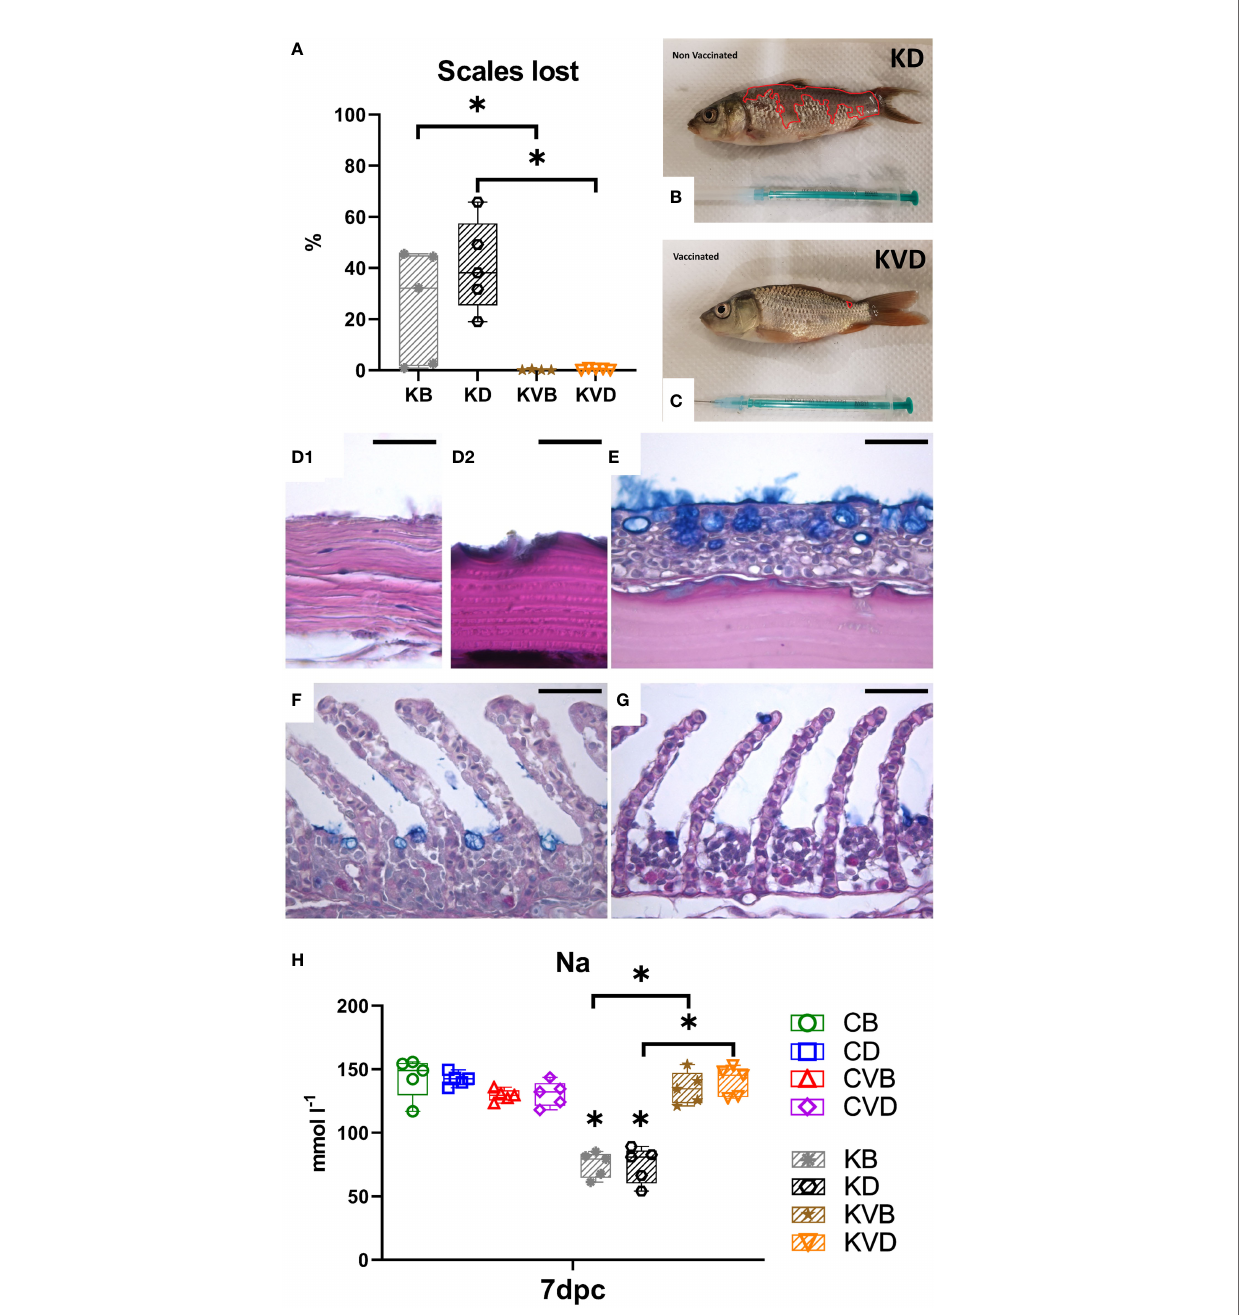
FIGURE 5 | Macroscopic, pathohistological and pathophysiological effect of the CyHV-3 challenge at 7 dpc. (A) Percentage of the body integument where scales were lost during the challenge. The surface area of (B) non-vaccinated and (C) vaccinated fi sh which lost scales are outlined in red. (D 1 ) Histology of the skin of non- vaccinated, CyHV-3 challenged fi sh which lost scales. (D 2 ) Histology of the skin of non-vaccinated, CyHV-3 challenged fi sh which had intact scales but lost the epithelium. (E) Histology of the skin of vaccinated fi sh showing scales covered with epithelium. (F) Histology of the gills of non-vaccinated, CyHV-3 challenged fi sh showing thickening of secondary lamella and some increase in cell proliferation in the intralammellar spaces. (G) Histology of the gills of vaccinated, CyHV-3 challenged fi sh showing secondary lamella of normal thickness and some increase in cell proliferation in the intralammellar spaces. (H) Sodium level in blood serum. The description of experimental groups: CB – BSA, non-vaccinated, unchallenged control, CD – defensins, non-vaccinated, unchallenged control, CVB – BSA, vaccinated, unchallenged control, CVD – defensins, vaccinated, unchallenged control, KB - BSA non-vaccinated, CyHV-3 challenged, KD – defensins non- vaccinated, CyHV-3 challenged, KVB – BSA, vaccinated, CyHV-3 challenged, KVD – defensins, vaccinated, CyHV-3 challenged. The results are presented as 25%- 75% box plots with min. and max. values as whiskers with indication of all data points. * indicates statistical signi fi cant difference at p < 0.05. Statistical analysis was performed with one-way ANOVA with the multiple comparisons test performed with Holm-Sidak